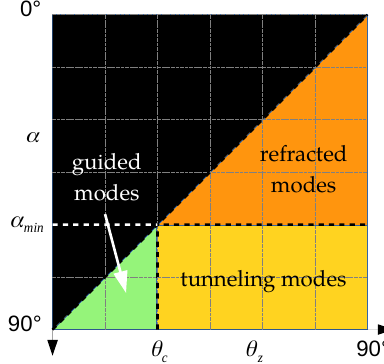
Figure 2. Mode categories of a step-index multi-mode fiber (SI-MMF).